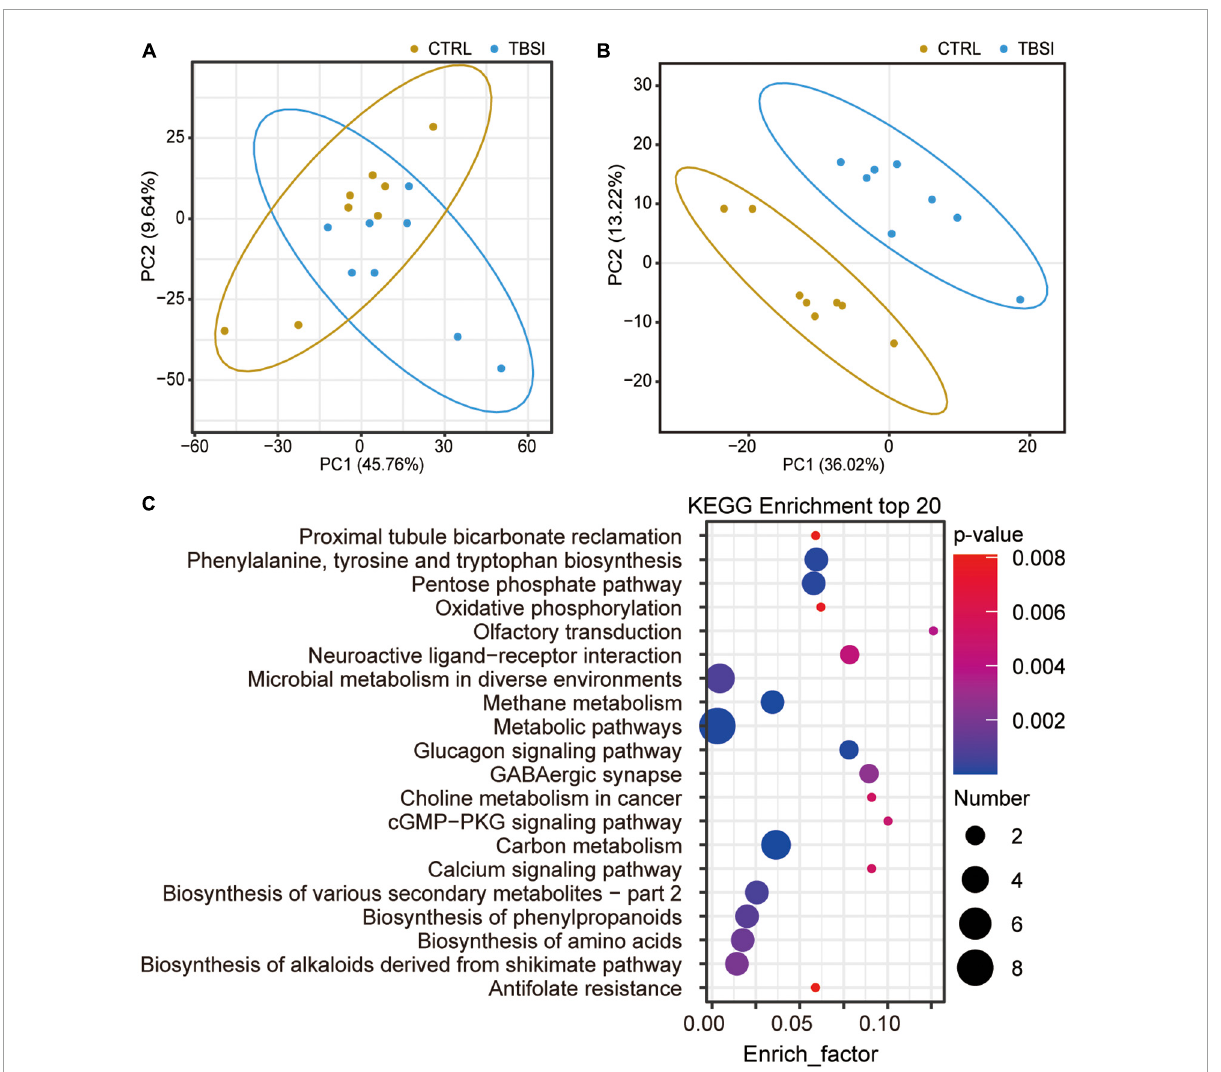
FIGURE5 Characterization of brainstem metabolomics. (A) PCA analysis of metabolic profiling results. The dots represent biological replicates from each group. (B) Score plot of PLS-DA model for classification of TBSI and CTRL groups. (C) KEGG analysis of potentially perturbed metabolic pathways associated with potential biomarkers in the TBSI